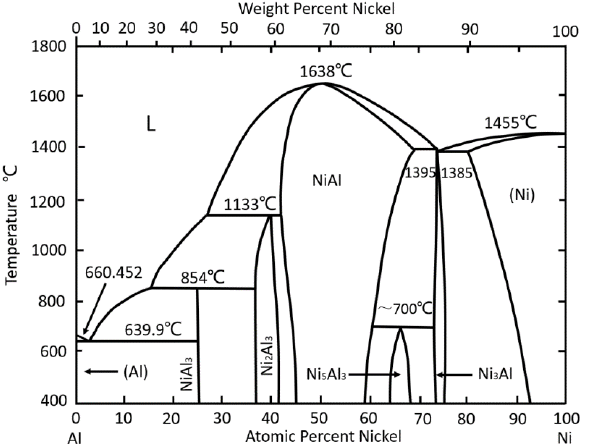
Figure 2. Binary phase diagram of the Ni-Al system. Reproduced from [24] with permission. Copyright 2002 Elsevier.